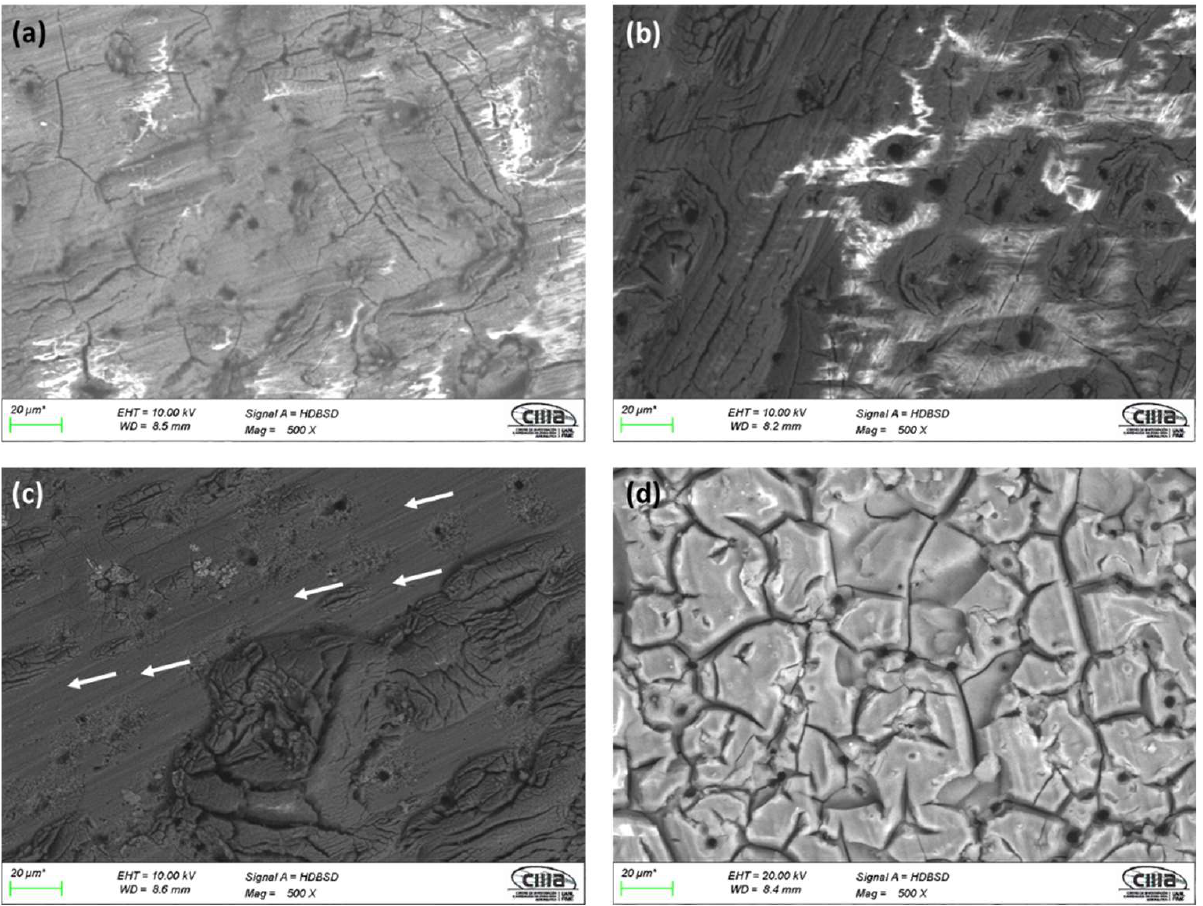
Figure 1. SEM-BSE surface morphology of anodized samples of AA2024 at 3 A/dm 2 : ( a ) 3A C1M S5, ( b ) 3A C1M S10, ( c ) 3A C1M, and ( d ) 3A